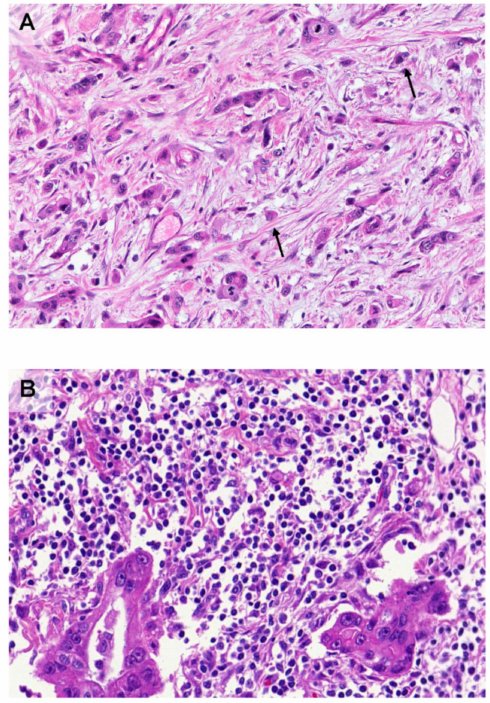
Figure 1. ( A ) PDAC with many tumor buds (arrows). The lack of immune cells in its microenvironment is evident. ( B ) PDAC with no tumor buds. Its microenvironment is particularly rich in immune cells. Hematoxylin-Eosin stained sections; ×